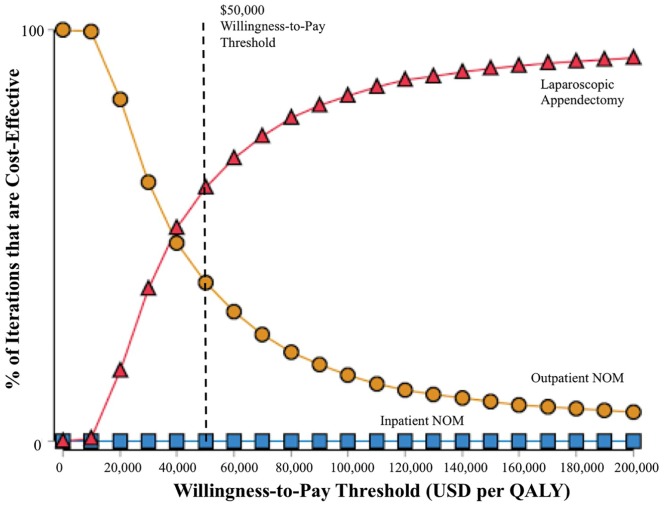
Cost-effectiveness acceptability curves from probabilistic sensitivity
analysis.